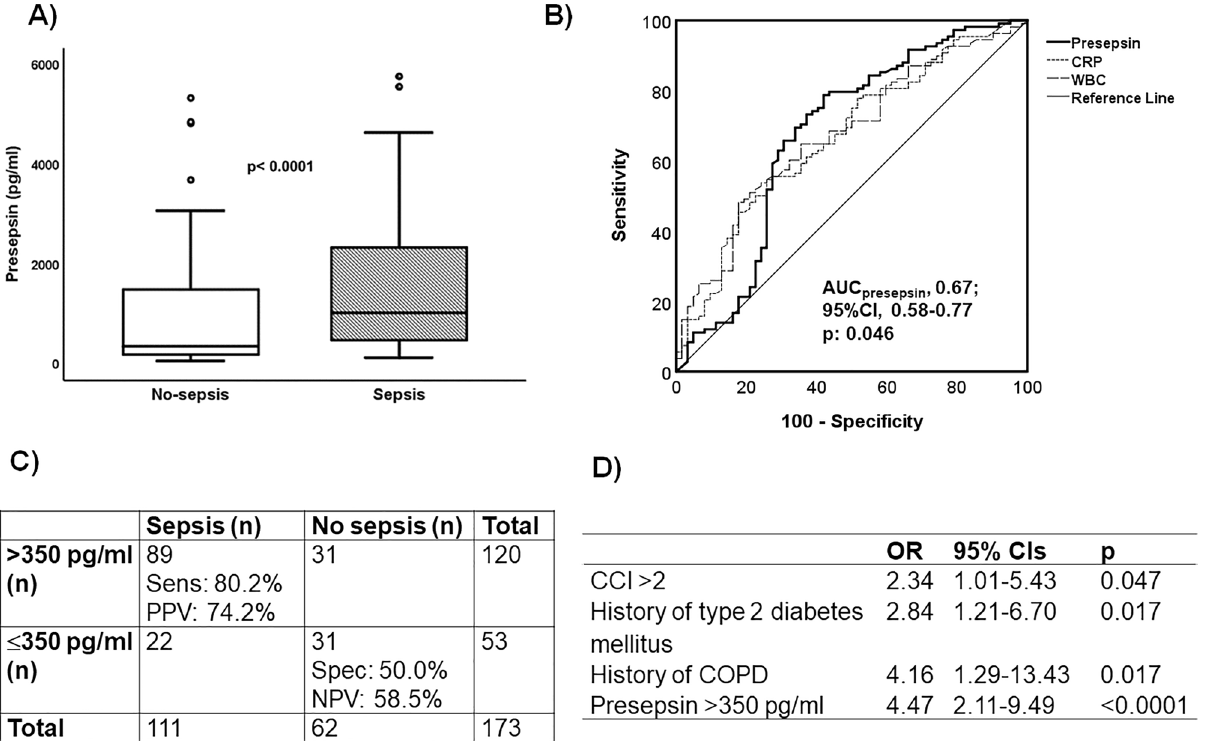
Figure 2. Diagnostic performance of presepsin for Sepsis using the Sepsis-3 definitions in the derivation cohort. ( A ) Box plots of the concentrations of presepsin among patients without sepsis and patients with sepsis. The p-value of the comparisons by the Mann–Whitney U test is shown. ( B ) Receiver Operator Characteristics (ROC) curve of presepsin for the diagnosis of sepsis; ( C ) diagnostic performance of the 350 pg/ml cut-off of presepsin for the diagnosis of sepsis; ( D ) stepwise (forward) logistic regression analysis of variables associated with classification into sepsis; only variables remaining significant after four steps of analysis are provided. AUC area under the curve, CCI Charlson’s comorbidity index, CI confidence interval, COPD chronic obstructive pulmonary disease, CRP C-reactive protein, NPV negative predictive value, OR odds ratio, PPV positive predictive value, WBC white blood cell